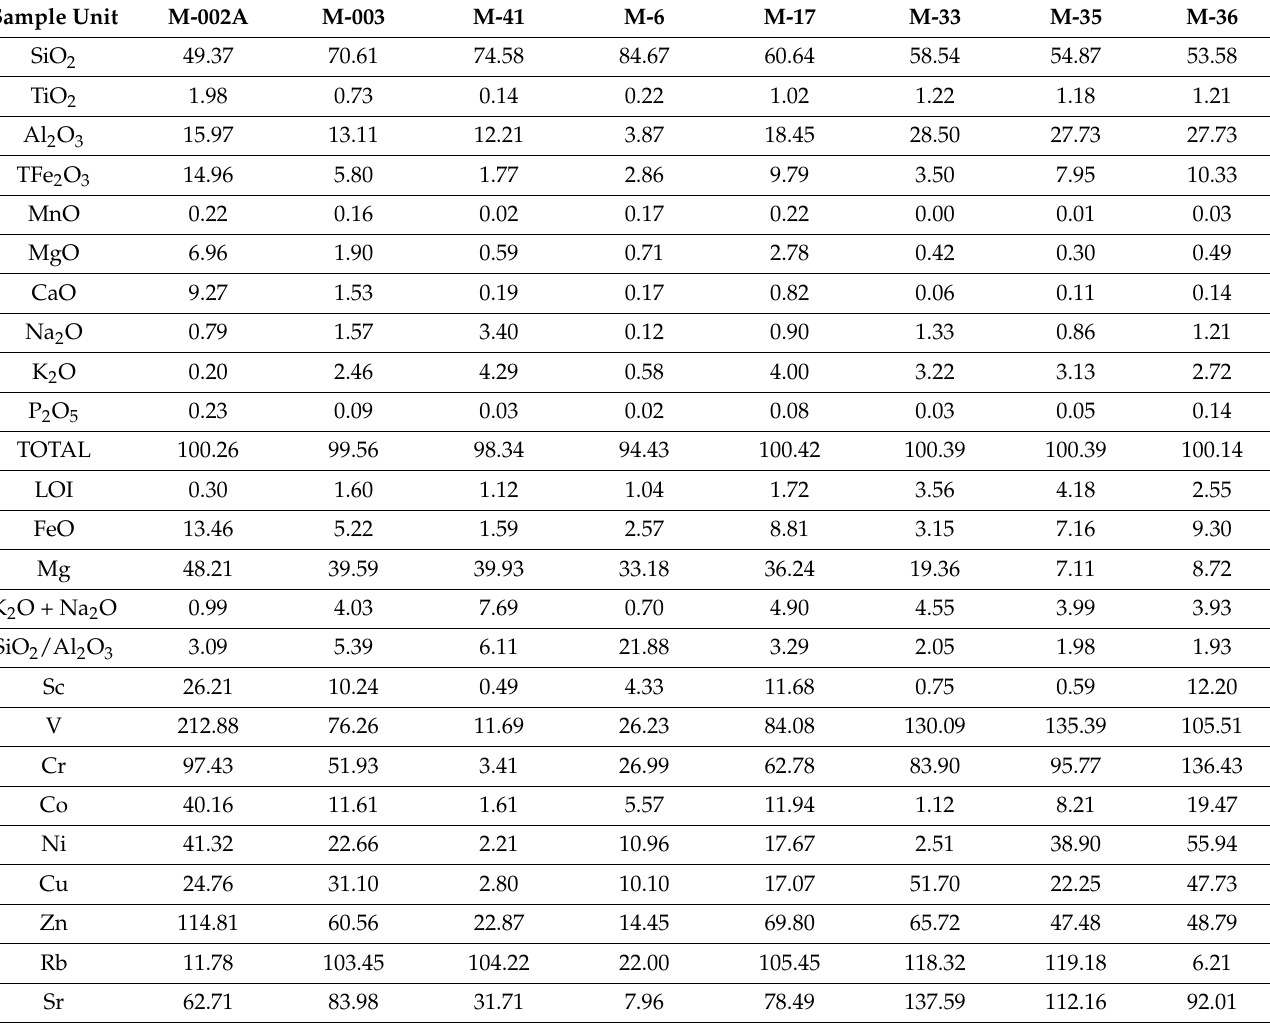
Table 2. Whole-rock major (wt%) and trace element (ppm) compositions of metamorphic rocks in the southernmost part of the Kumon range and Katha-Gangaw range, northern